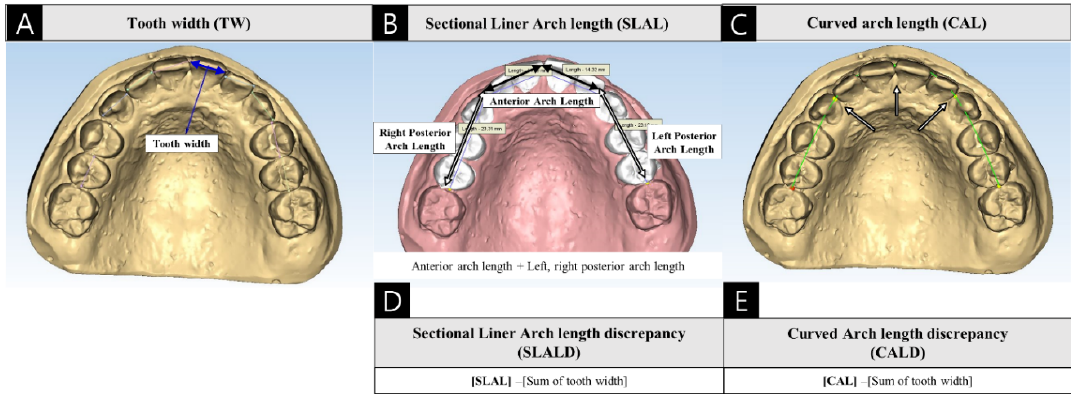
Figure 3. ( A ) Measurement of the mesial-distal width of the tooth and the arch length. ( B ) Sectional liner arch length (SLAL) measured using Maestro 3D ® . ( C ) Automatically designed curved arch length (CAL) using Maestro 3D ® . ( D ). Definition of sectional full arch length discrepancy (SLALD). ( E ) Definition of digital full arch length discrepancy